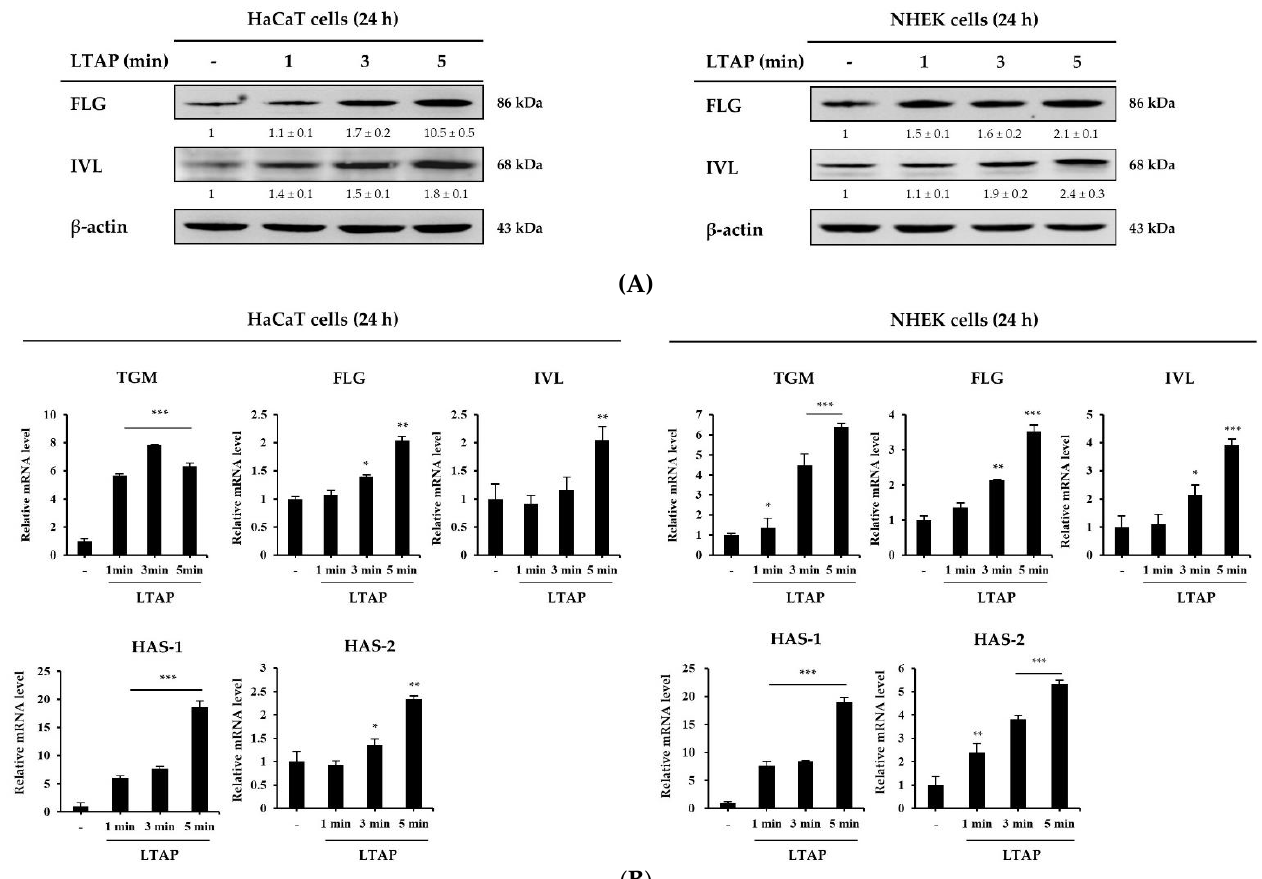
Figure 1. Effects of low-temperature argon plasma (LTAP) on the skin barrier and moisturizing factors in human epidermal keratinocyte cell line HaCaT and normal human epidermal keratinocytes (NHEKs). HaCaT cells and NHEKs were exposed to LTAP for 1, 3, or 5 min, and further incubated for 24 h. ( A ) Expression of filaggrin (FLG) and involucrin (IVL) was determined by Western blotting. Numerical values on the blots represent DU. The control was normalized to 1 DU. All data represent three independent experiments. ( B ) Expression of skin barrier and moisturizing-related genes ( tansglutaminases (TGM), FLG, IVL and hyaluronic acid synthase-1, 2 (HAS-1, 2 )) was measured by quantitative real-time PCR (qRT-PCR) in HaCaT cells and NHEKs. Results are expressed as the mean ± SD of three independent experiments. * p < 0.05, ** p < 0.01, *** p < 0.001 (control vs. LTAP-exposed cells).